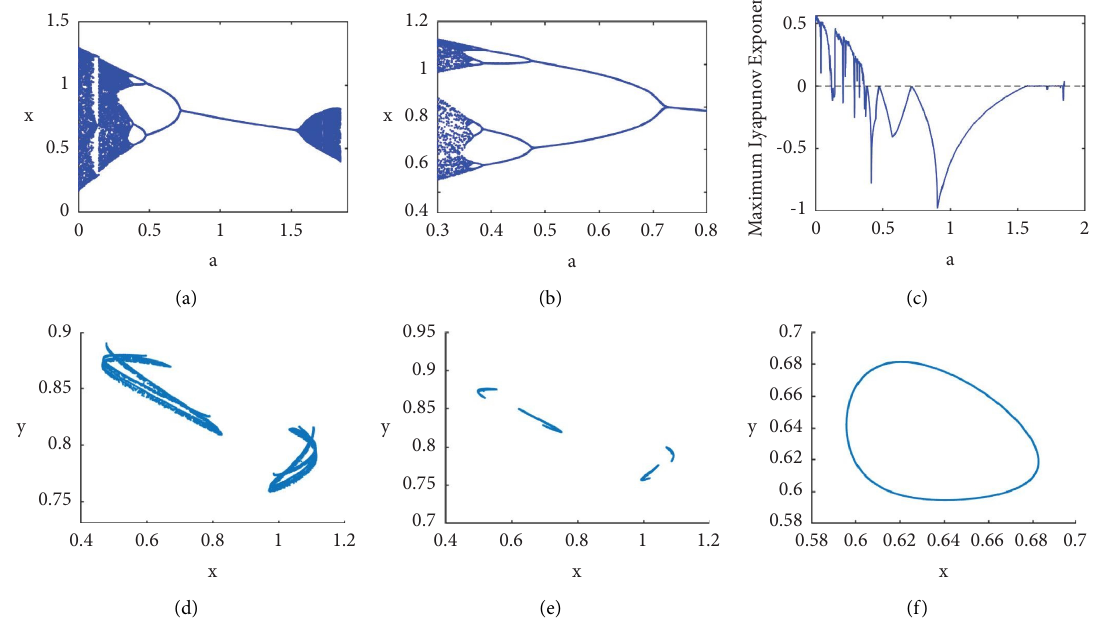
Figure 7: (a) Bifurcation diagram of the model (4) in ( a,x ) plane. (b) Local amplifcation for a ∈ ( 0 . 3 , 1 . 2 ) corresponding to (a). (c) Maximum Lyapunov exponents corresponding to (a). Phase-plane diagrams for various values of a corresponding to Figure 6(a): (d) a � 0 . 315, (e) a � 0 . 353, and (f) a � 1 . 57799.